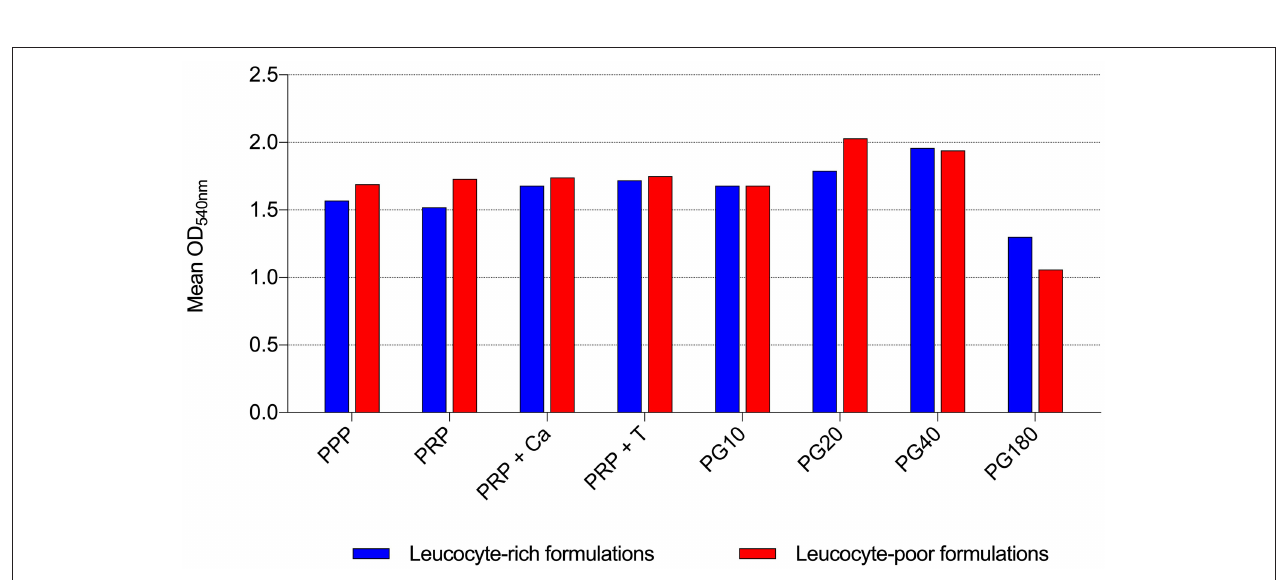
FIGURE 8 | Mean OD 540nm values of leukocyte-rich formulations and leukocyte-poor formulations observed after 24h of incubation in the presence of different non-transfusional hemo-components. PPP, platelet-poor plasma; PRP, platelet-rich plasma; PRP + Ca, platelet-rich plasma with calcium gluconate; PRP + T, platelet-rich plasma with thrombin-rich solution; PG10, platelet gel 10 µ l; PG20, platelet gel 20 µ l; PG40, platelet gel 40 µ l; PG180, platelet gel 180 µ l.